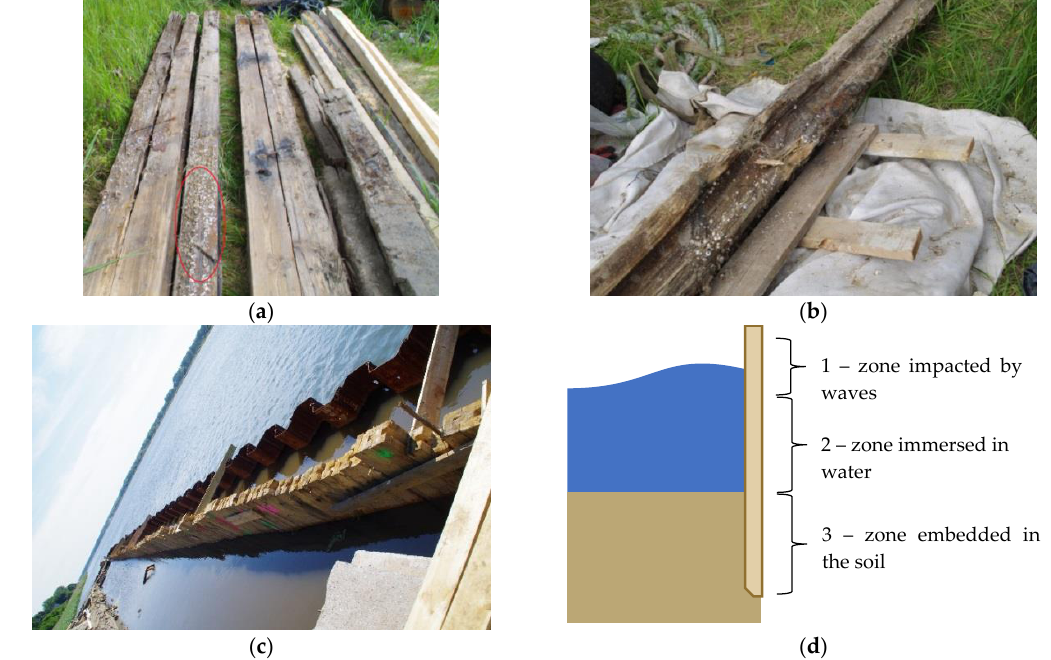
Figure 1. ( a , b ) View of wharf timber sheet pile wall from which samples were taken for testing (the zone impacted by waves is marked with red ellipse); ( c ) view of rebuilt wharf timber sheet pile wall; ( d ) scheme of the global structure with the location of the specimens.